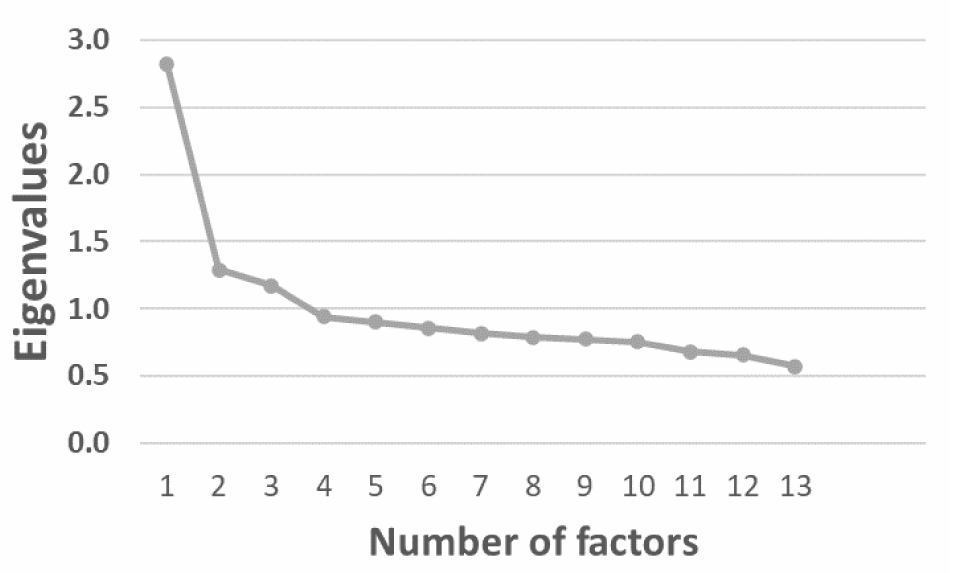
Figure 2. Scree plot of eigenvalues of latent factors extracted from factor analysis. The scree plot shows the eigenvalues of factors from factor analysis, with eigenvalue of the y-axis and the number of factors on the